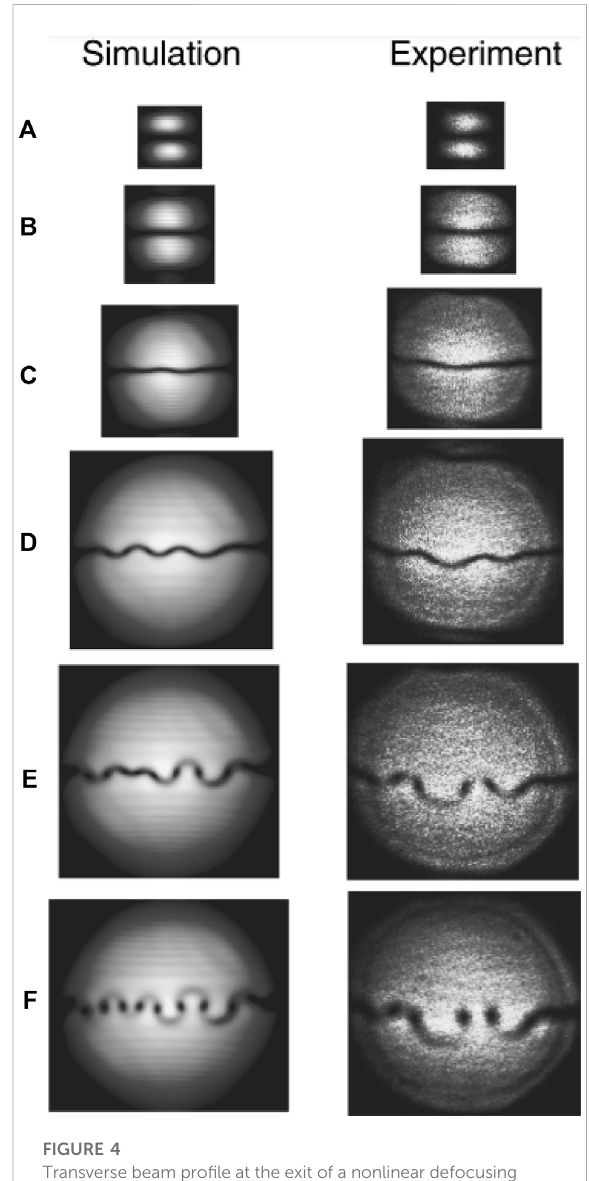
FIGURE 4 Transverse beam pro fi le at the exit of a nonlinear defocusing medium (a cell fi lled with gas), showing the instability of the edge WF dislocation (dark line) with an increase in the nonlinearity parameter (gas concentration) (A-F) (left column) theoretical calculation, (right column) experimental results. The concentration of cesium vapor increases from negligible values with non-linearity absent (A) to approximately 10 13 cm − 3 (F)